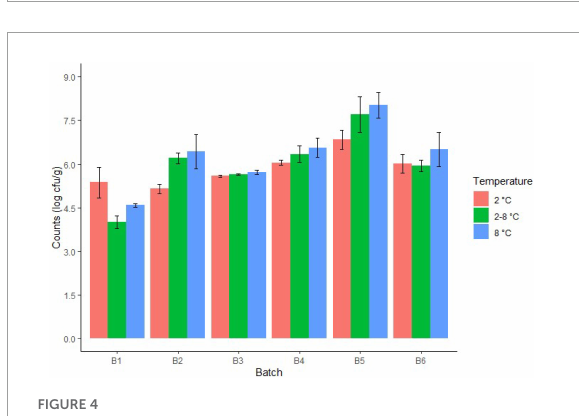
FIGURE4 Total bacteria counts in cheeses from different batches after 15 days of storage at different